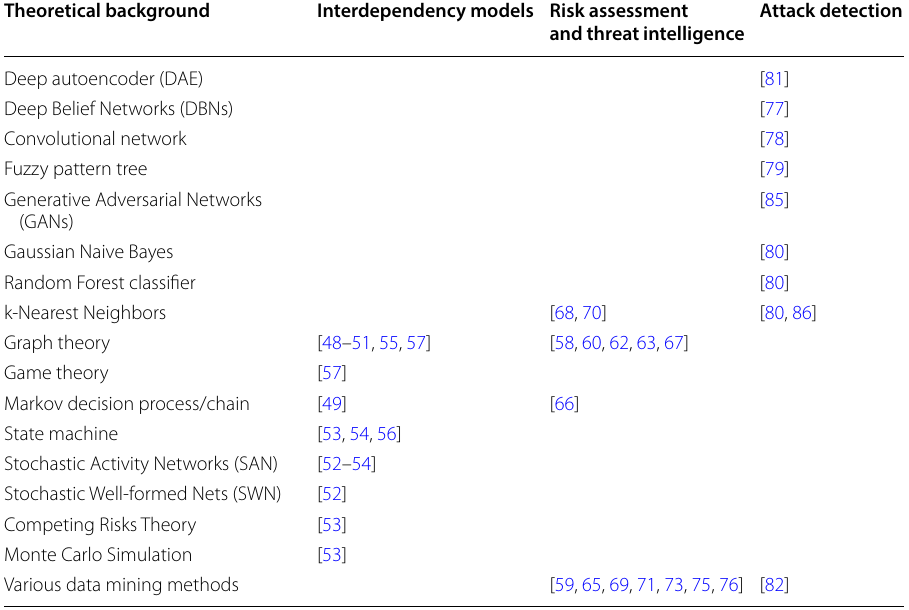
Table 2 Mapping of theoretical background and reviewed methods Theoretical background